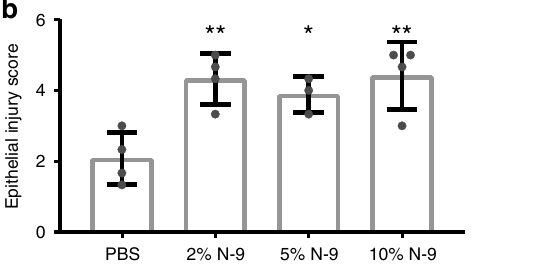
60.05 ± 4.97 h, P = 0.985 for 2%; 58.1 ± 3.58 h, P = 0.999 for 5%; 64.34 ± 4.18 h, P = 0.49 for 10%; and 68.3 ± 3.66 h, P = 0.2 for 40% N-9; pup survival 97.8 ± 2.2%, P > 0.999 for 2%; 98 ± 2%, P > 0.999 for 5%; 96.75 ± 2.14%, P > 0.999 for 10%; and 90.6 ± 6.49%, P = 0.9486 for 40% N-9, Dunnett ’ s multiple comparisons test).